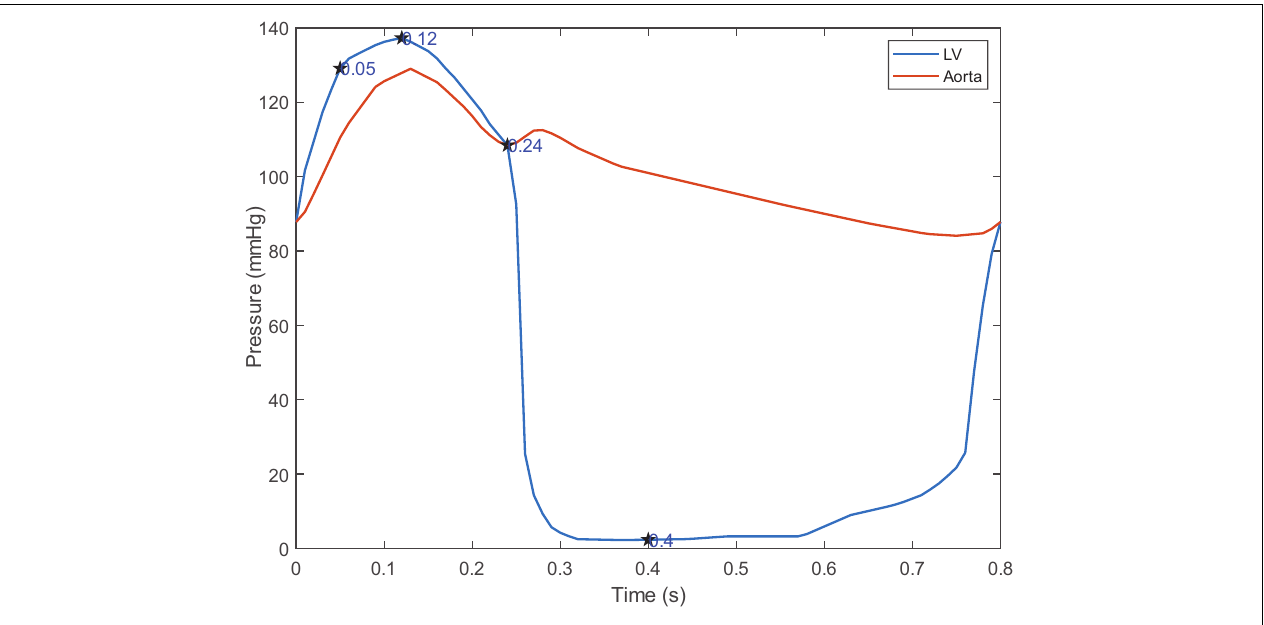
FIGURE 4 | Pressure waveforms for boundary conditions and four characteristic